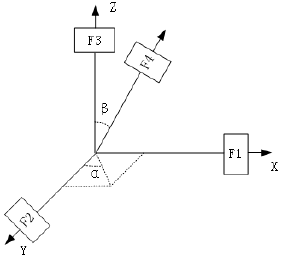
Figure 7. Configuration of the three-orthogonal flywheel with one-skewed flywheel.